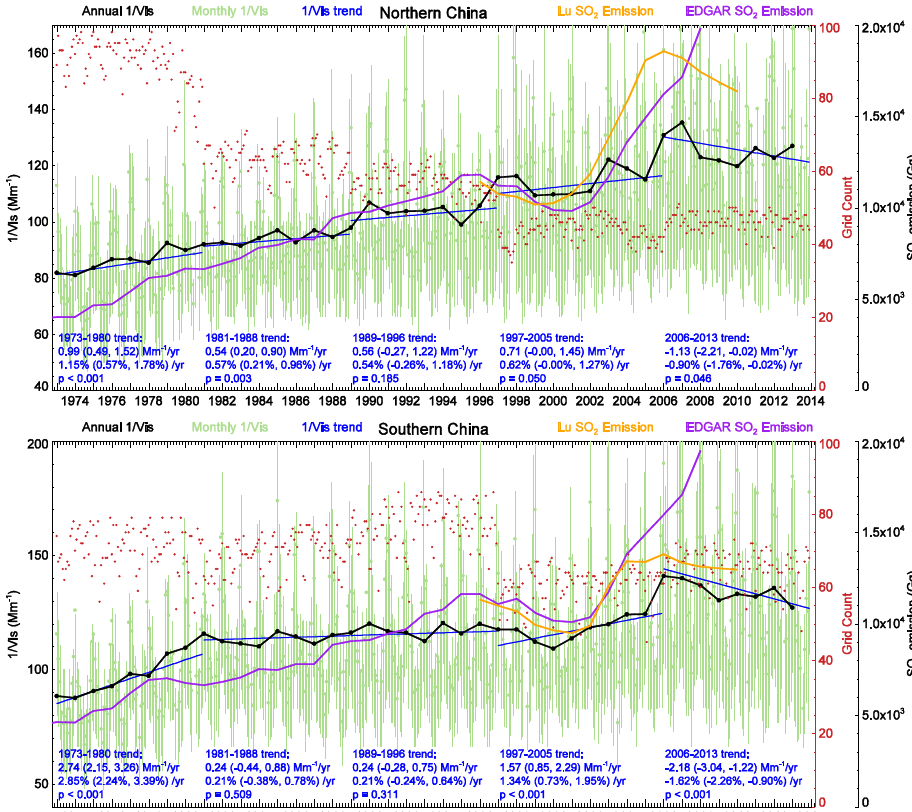
Figure 12. Regional time series analysis of 1/Vis and SO 2 emission over southern and northern China. The long ticks on the horizontal axis indicate January of the year, where all annual values are plotted. Light green dots represent the average monthly 1/Vis of all qualified stations (error bars showing the 25th and 75th percentile) in the defined region. Red dots show the number of grid cells for averaging, and data gaps indicate months with less than 75% of the total grids for each period. Blue lines and text represent the 1/Vis trends calculated using the monthly anomalies for each period. Trends in parentheses are the 95% confidence intervals. Black lines are the annual 1/Vis averaged from at least 8 monthly values. The SO 2 emission in Lu et al. (2011) in orange and the EDGAR SO 2 emission in purple are summed from all pixels inside the defined region (Fig.